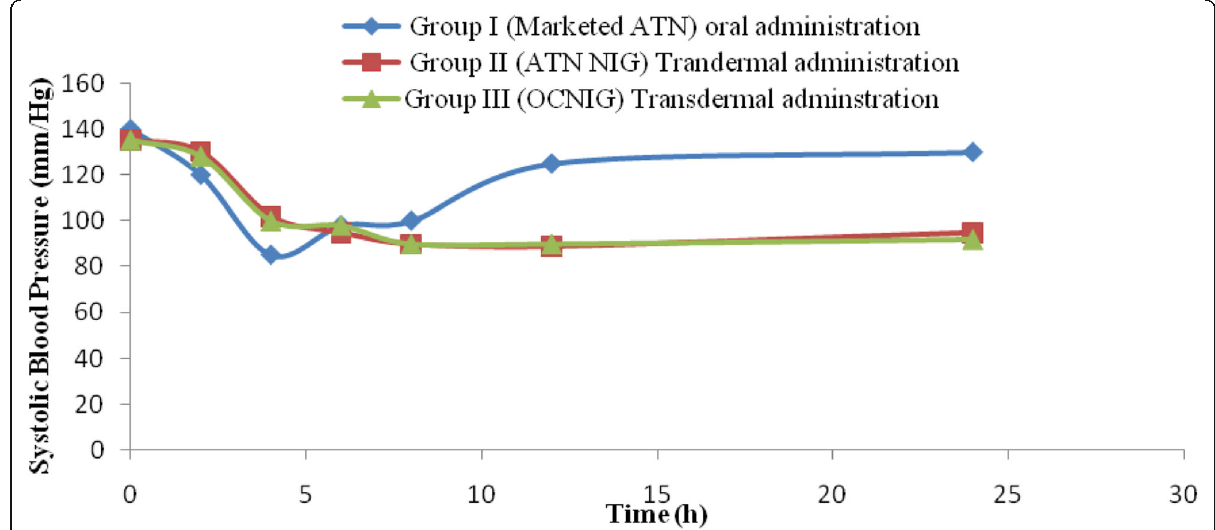
Fig. 11 Showing changes in systolic blood pressure (mm Hg) after oral administration of ATN suspension, ATN NIG, and OCNIG in methyl prednisolone acetate-induced hypertensive Wistar albino rats. * P < 0.002, significant difference in blood pressure with respect to oral treated group ( n = 6, Mean ±